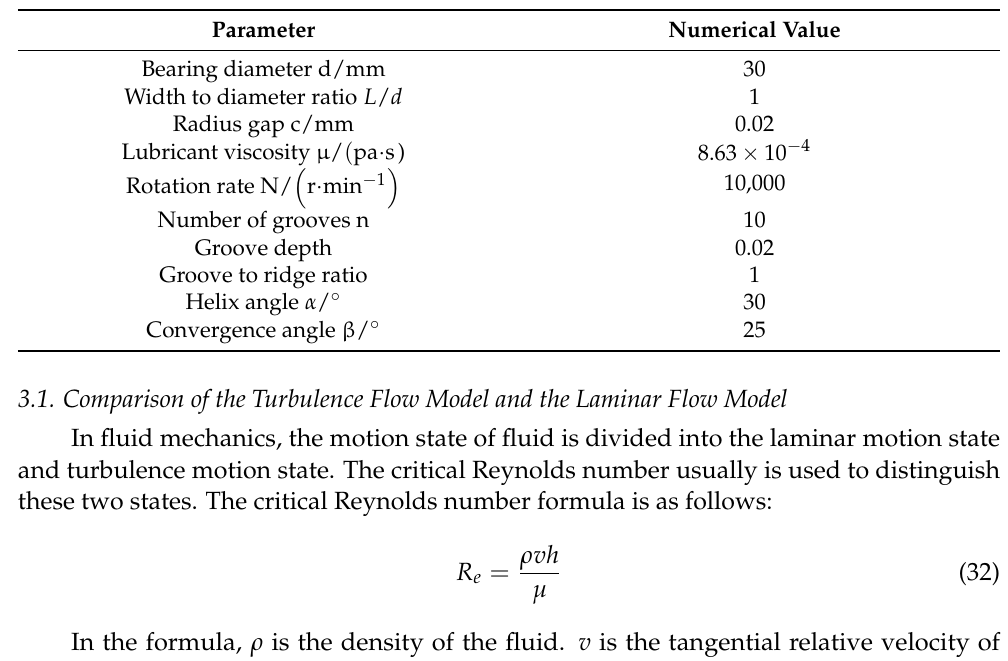
Table 1. Calculation parameters of HGJBs and lubricants.